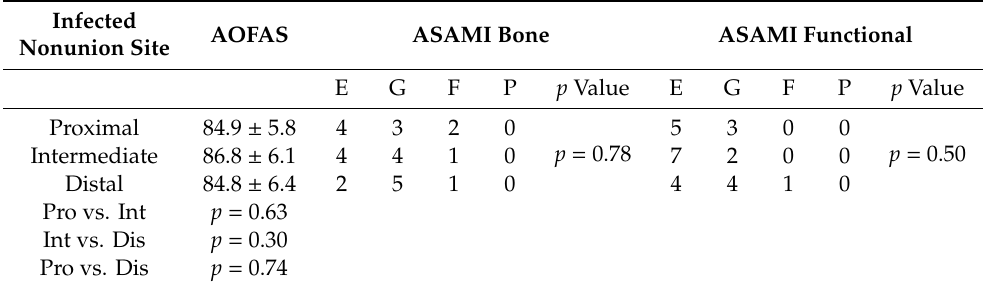
Table 3. Comparison between the results of the di ff erent infected nonunion sites using the AOFAS and ASAMI Bone and Functional Scoring System.